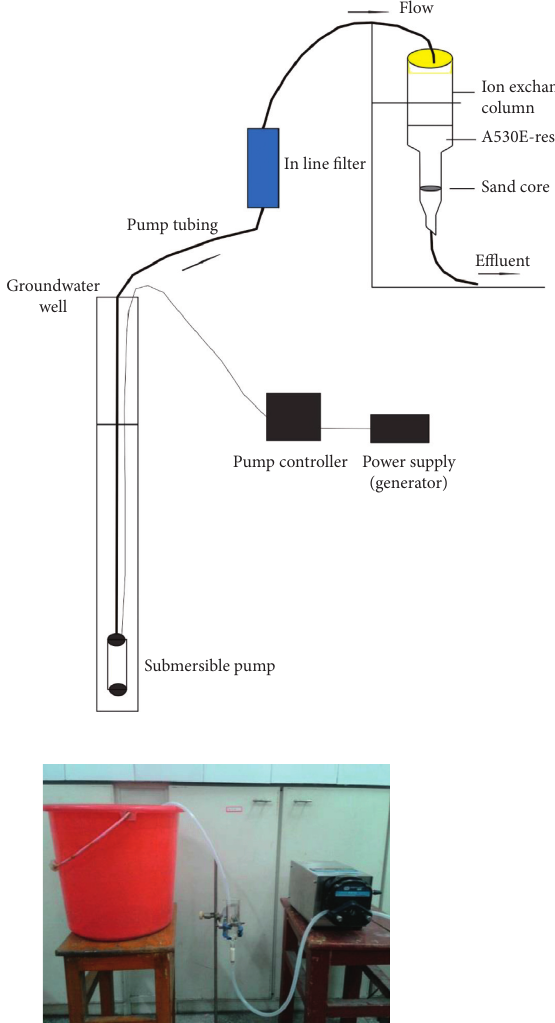
Figure 1: Sample collection device [41] (the left picture is the device used in the lab by